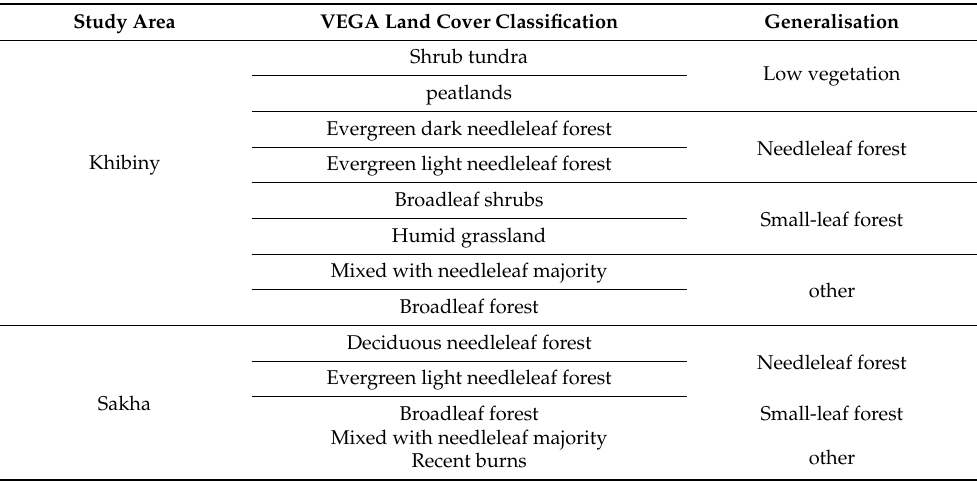
Table 4. Generalisation of land cover maps. Column 2 gives the land cover classification from the VEGA system; column 3 shows the generalisation by merging these classes. Generalised class names are arbitrary and have no ecological